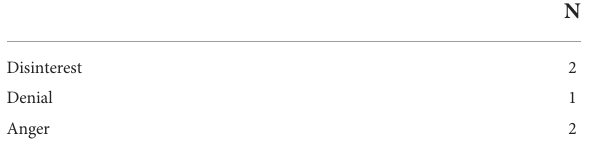
TABLE 3 Patients and their